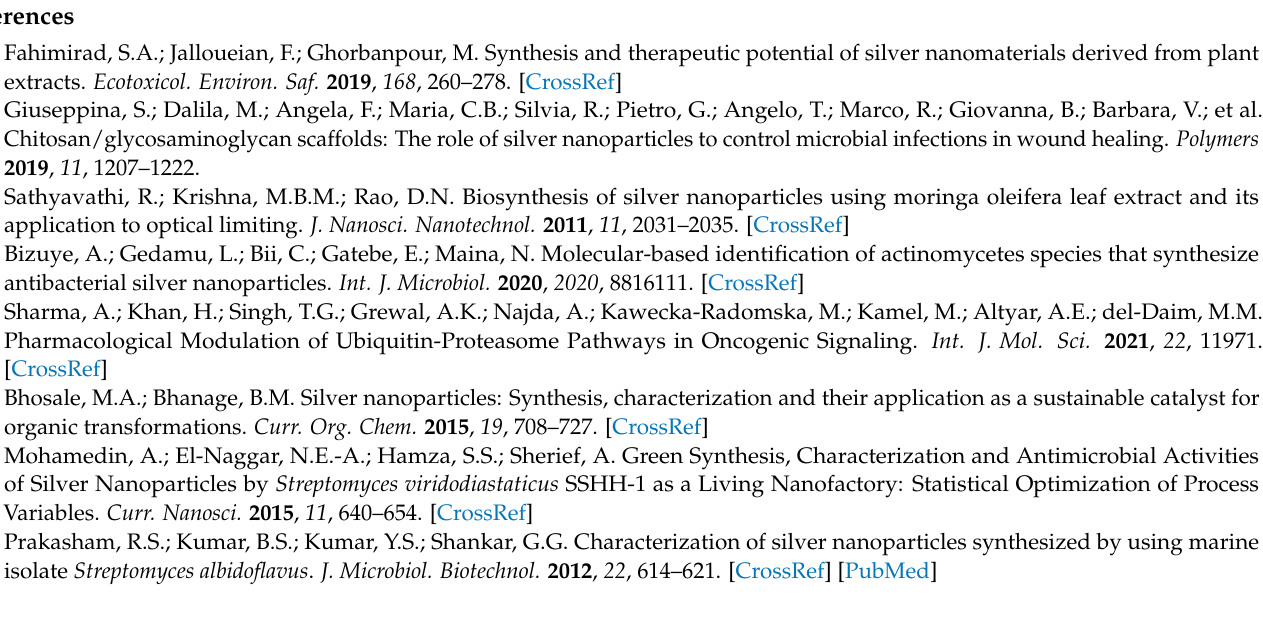
Figure S2: Zeta potential of silver nanoparticles produced by Streptomyces aizuneusis ATCC 14921 using zeta sizer analyzer; Figure S3: X-ray diffraction of silver nanoparticles produced by Streptomyces aizuneusis ATCC 14921. Position ( ◦ 2 θ ) (copper